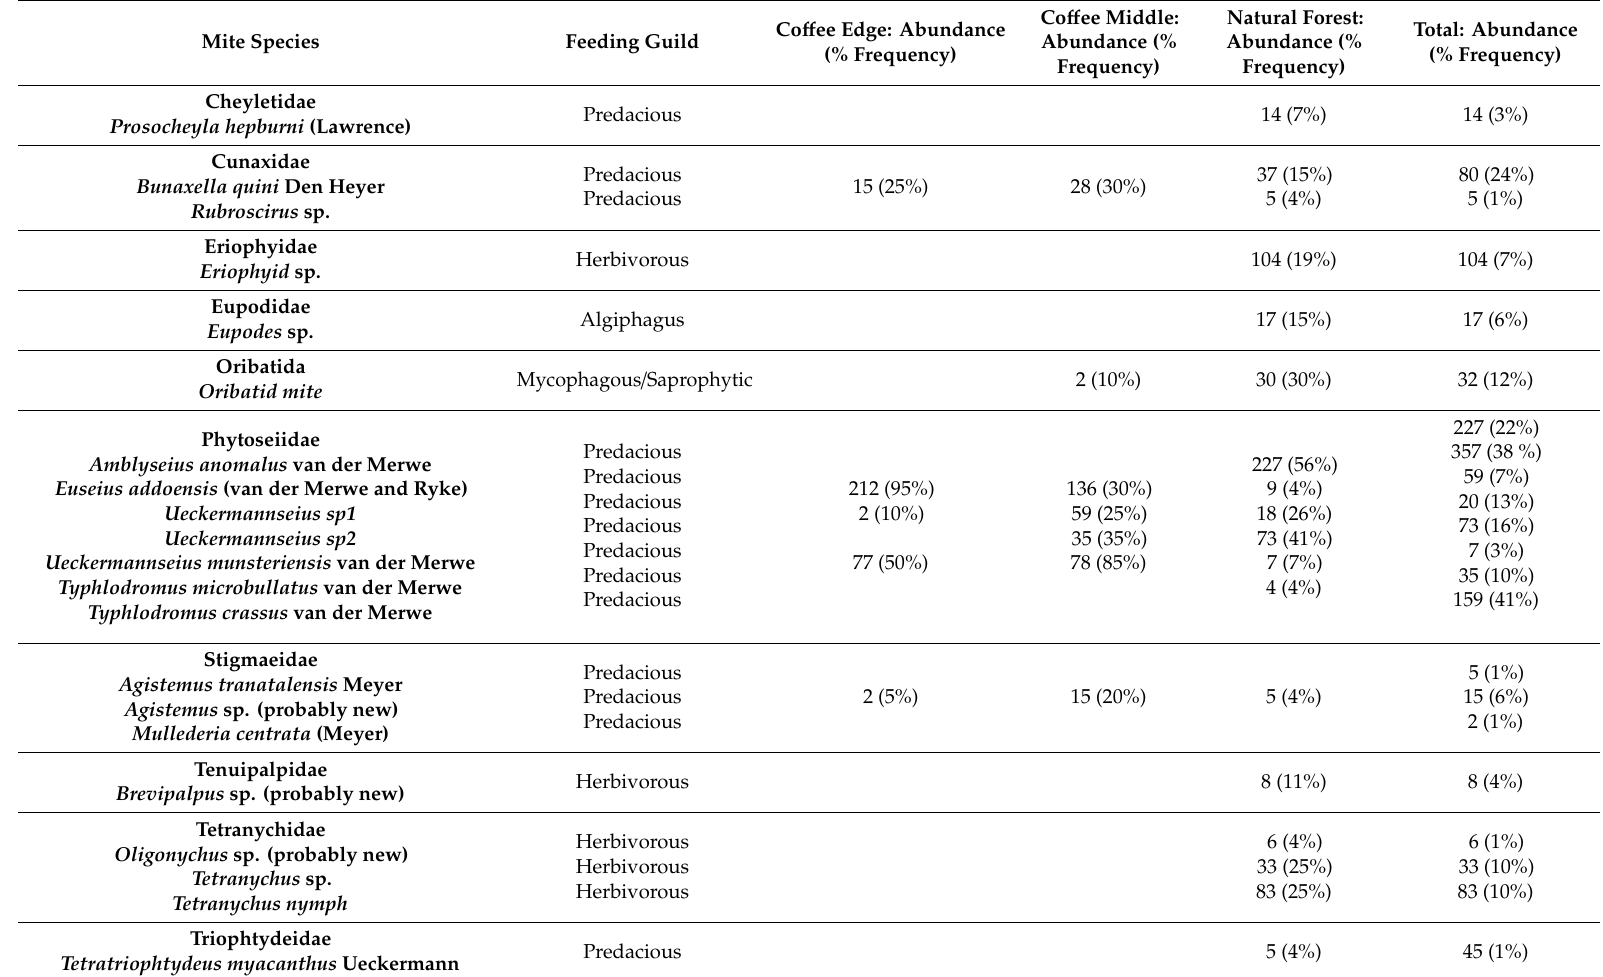
Table 1. A list of the mite species collected from the co ff ee plantation and the neighbouring Umtamvuna forest. Here, we have indicated the total abundance and frequency (i.e., the percentage number of samples in which each mite was found), for each of the sampled locations. Mite Species Feeding Guild